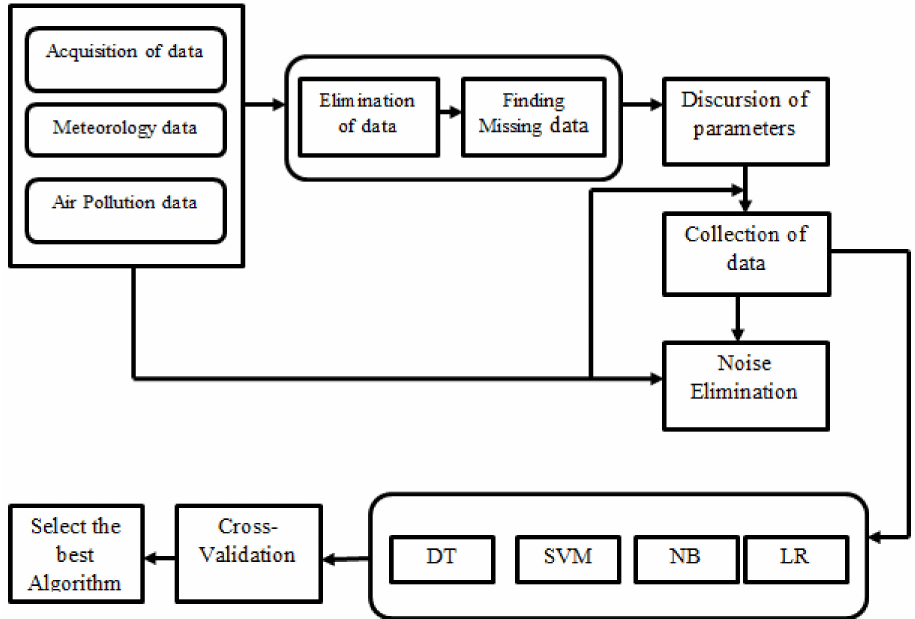
Figure 4. Air pollution model and quality predicting